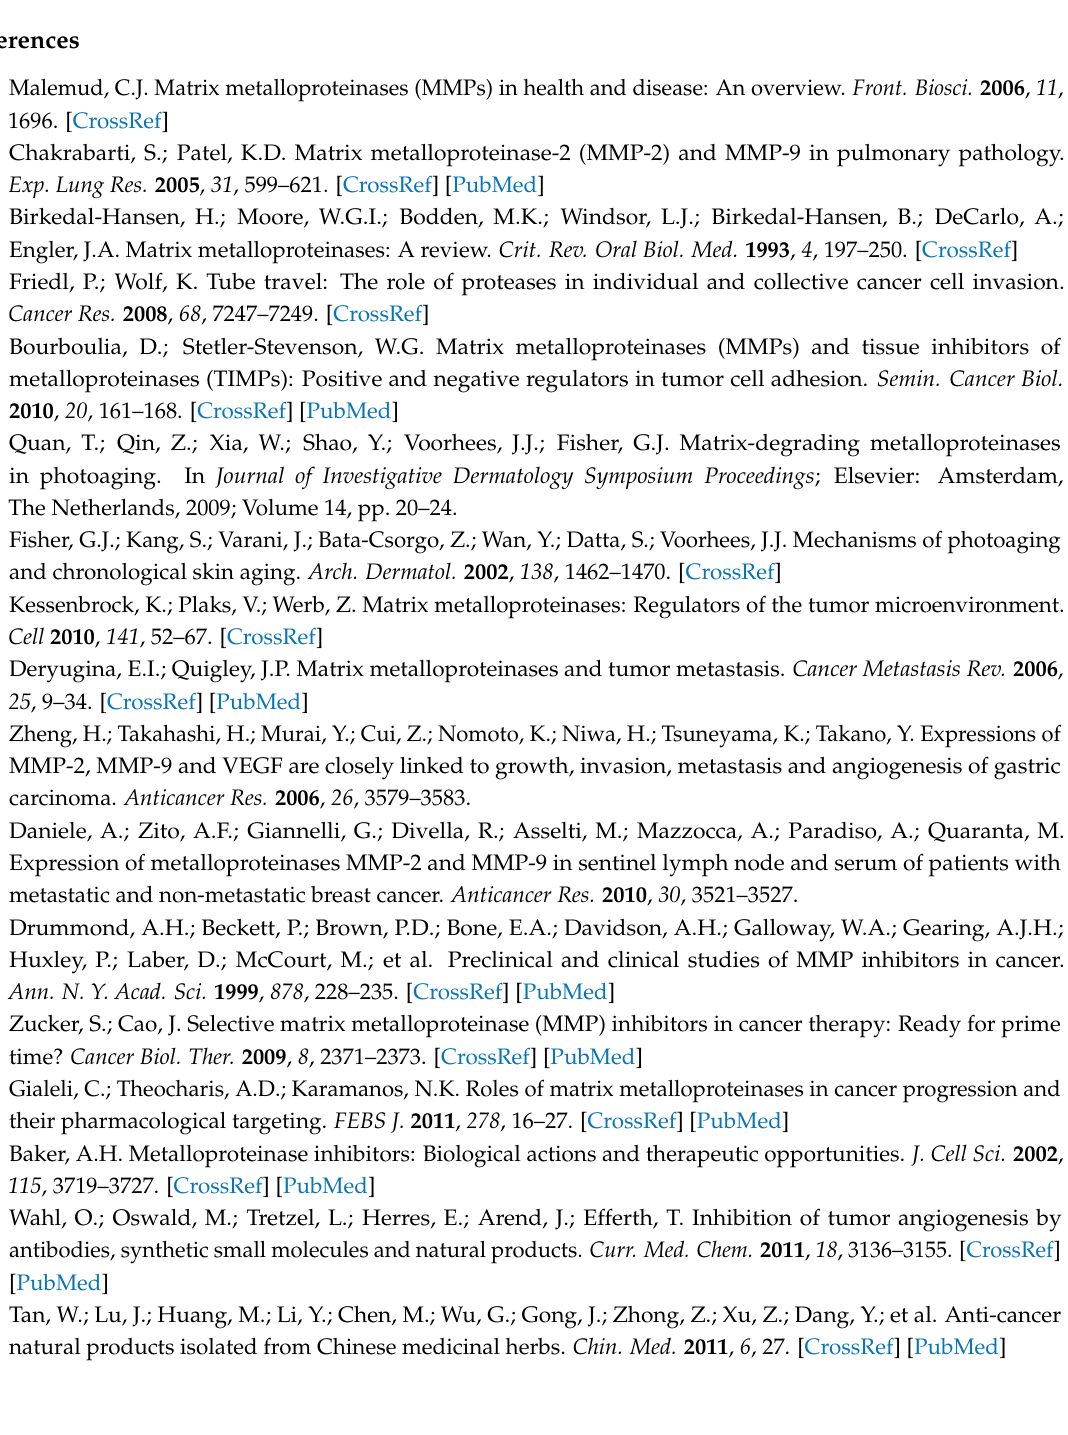
Supplementary Materials: The following are available online, Figure S1: 1 H-NMR Spectrum of GL-3 ( 1 ) (MeOH-d4, 900 MHz), Figure S2: 13 C-NMR Spectrum of GL-3 ( 1 ) (MeOH-d 4 , 900 MHz), Figure S3: 1 H-NMR Spectrum of oleonuezhenide ( 2 ) (MeOH-d 4 , 900 MHz), Figure S4: 13 C-NMR Spectrum of oleonuezhenide ( 2 ) (MeOH-d 4 , 900